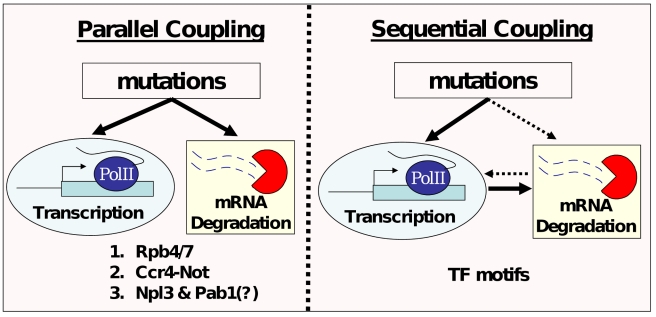
Two models of mechanistic coupling whereby individual mutations affect both transcription and mRNA degradation.The first model (Parallel coupling, left) assumes mutations in a single trans-factor that influences both processes and is consistent with the enrichment of trans-coupled genes with targets of Rpb4, Ccr4-Not, Pab1, and Npl3. The second model (Sequential coupling, right) assumes mutations that exert transcriptional effects (either in cis or in trans) and that these transcriptional effects then induce changes in mRNA degradation, for example, through a shuttling mechanism whereby Rpb4/7 (or other transcription-related molecules) binds to the mRNA co-transcriptionally and transports with it to the cytoplasm. This model is consistent with the enrichment of diverged TF motifs among cis-coupled genes. An opposite sequential coupling is also possible (dashed arrows), whereby mutations affect mRNA degradation and this effect then induces transcriptional changes, yet we do not find evidence to support it.